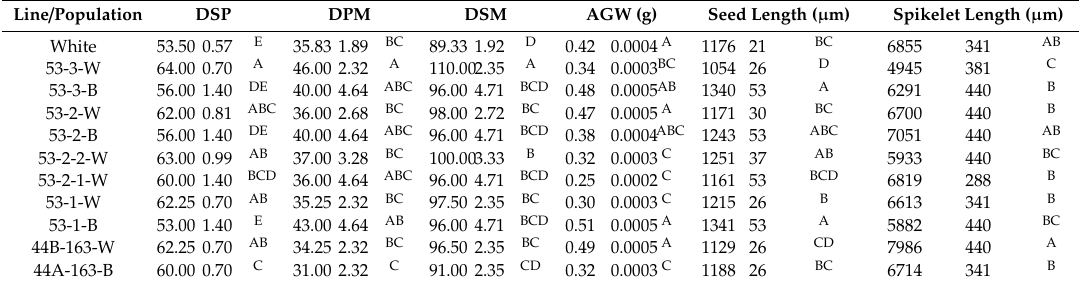
Di ff erent letters indicate significant di ff erences at p <